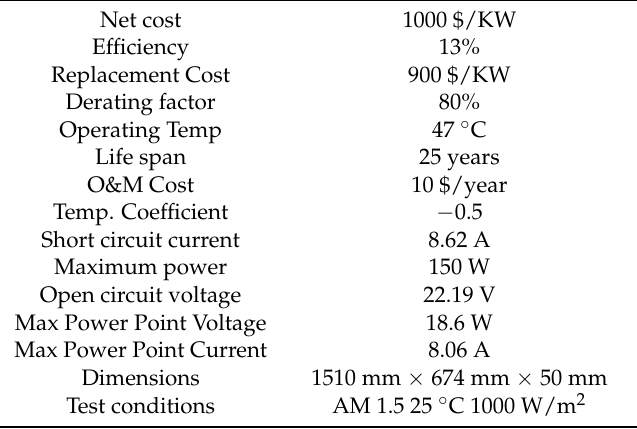
Table 1. Specifications and cost considerations of solar PV modules.